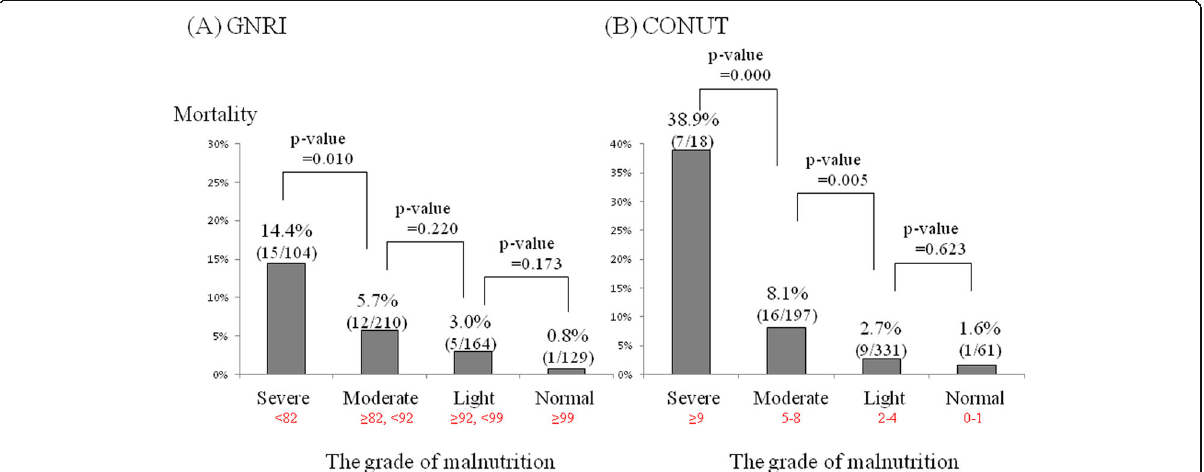
Fig. 1 The relationship between the grade of malnutrition and the proportion of 180-day mortality rate in each risk model is shown. In the GNRI, the mortality rates in the severe group (< 82), moderate group ( ≥ 82, < 92), low group ( ≥ 92, < 99), and normal group ( ≥ 99) were 14.4%, 5.7%, 3.0%, and 0.8%, respectively ( a ). In the CONUT, the mortality rates in the severe group ( ≥ 9), moderate group (5 – 8), low group (2 – 4), and normal